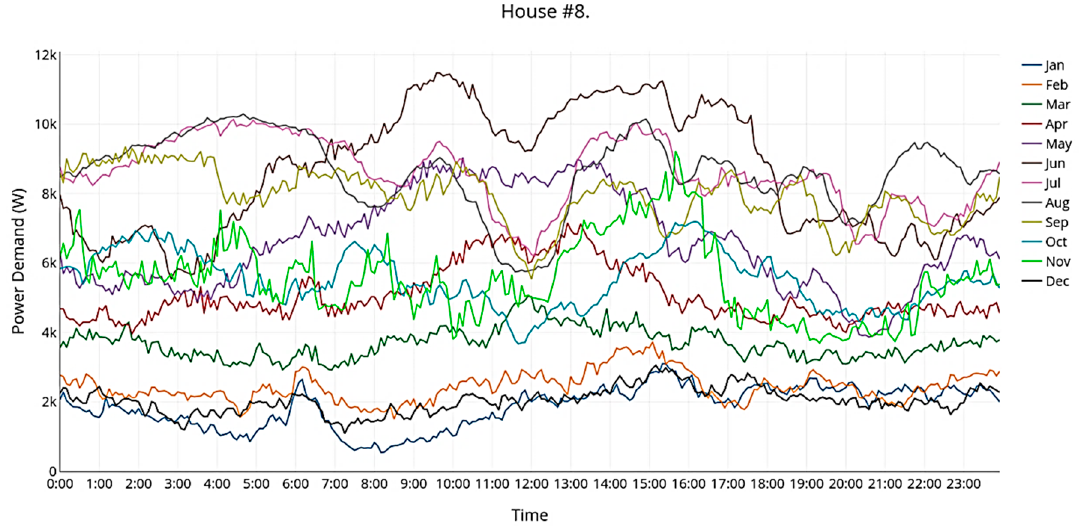
Figure 4. Daily electricity load profiles of Houses 1, 2, 6, 7 & 8 (July 2017 and August 2018).